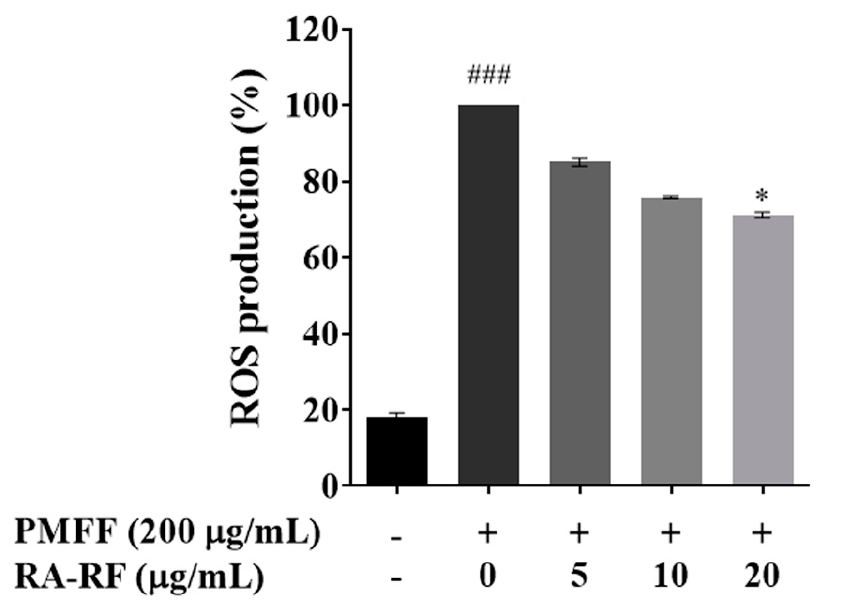
Figure 2. The intracellular ROS production in A549 cells exposed to PMFF (200 µ g/mL) by the presence of RA-RF (0–20 µ g/mL). The mean ± SEM are shown as ### p < 0.001 vs. the control group; * p < 0.05 vs. PMFF group. The data were independently performed in triplicate.